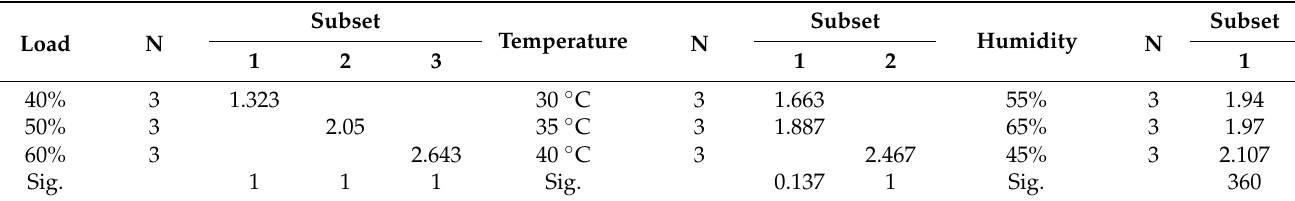
Table 5. Pairwise comparison S-N-K test.